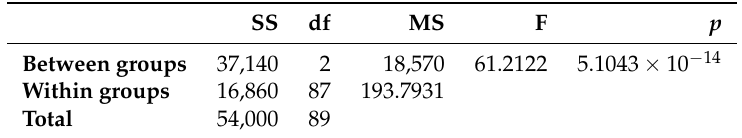
Figure 6. Task 3-user preference level in dynamic sound volume change using three different haptic technologies: ( a ) distribution per treatment, ( b ) mean and standard deviation, ( c ) evaluation function of users’ age. Table 3. Kruskal Wallis test for Task3.